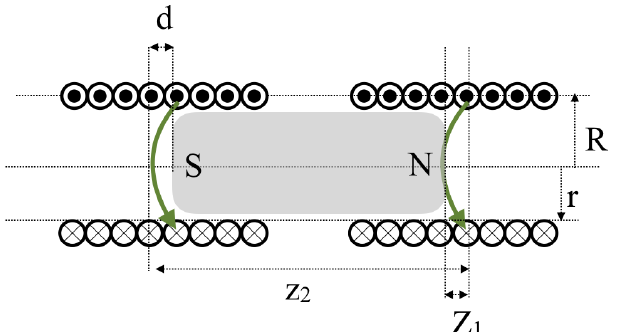
Figure 3. Schematic configuration of ESA composed of two solenoids and a shared magnetic core in the